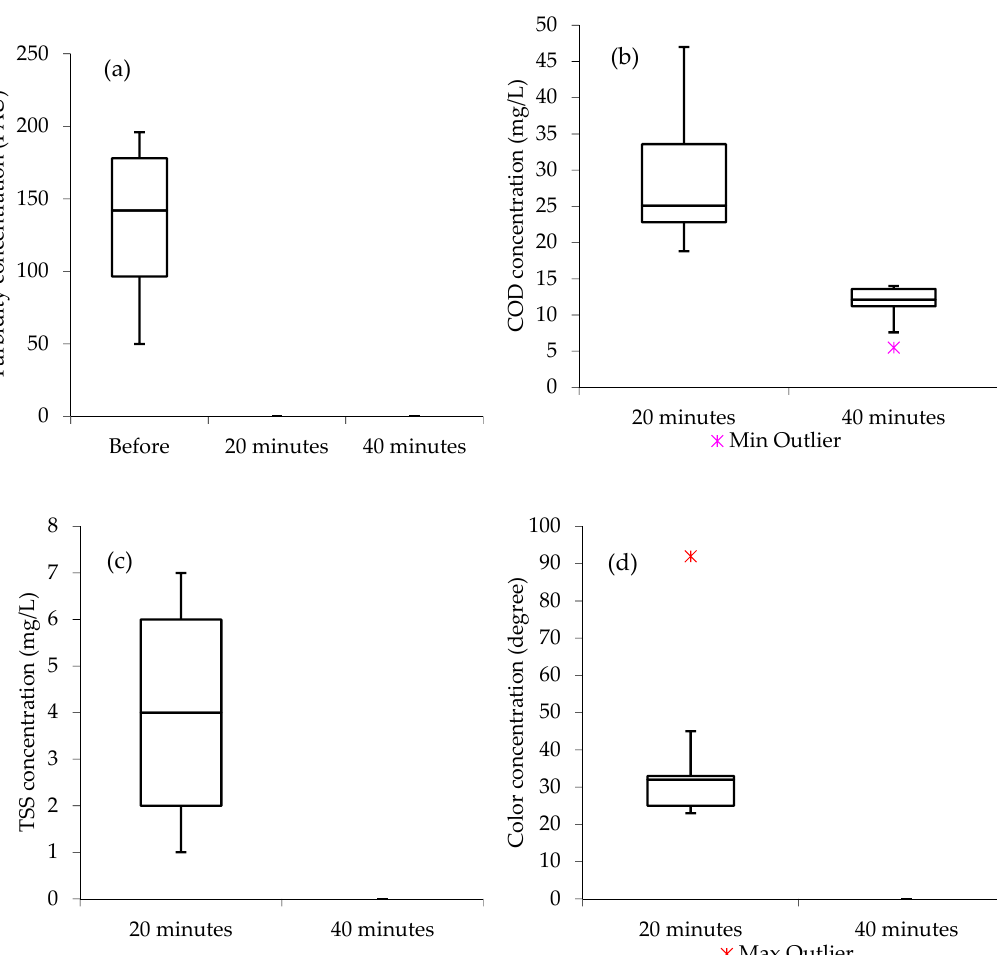
Table 7. Correlation of some physicochemical parameters from the Al–Ti combination.